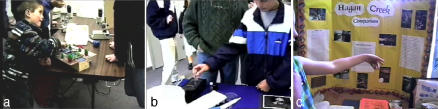
The Open-House EventThese video offprints from a public open-house event organized by an environmentalist group feature moments where students helped others to learn about the creek.